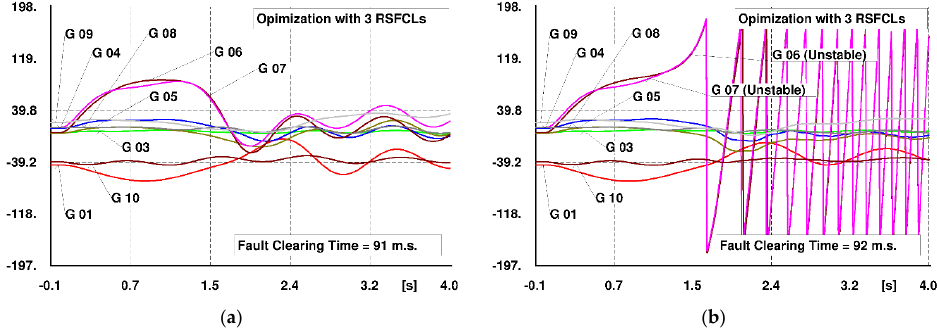
Figure 11. CCT in Scenario 1 (3 RSFCLs) for the considered short-circuit fault. ( a ) FCT = 91 m.s. (stable), ( b ) FCT = 92 m.s. (unstable).